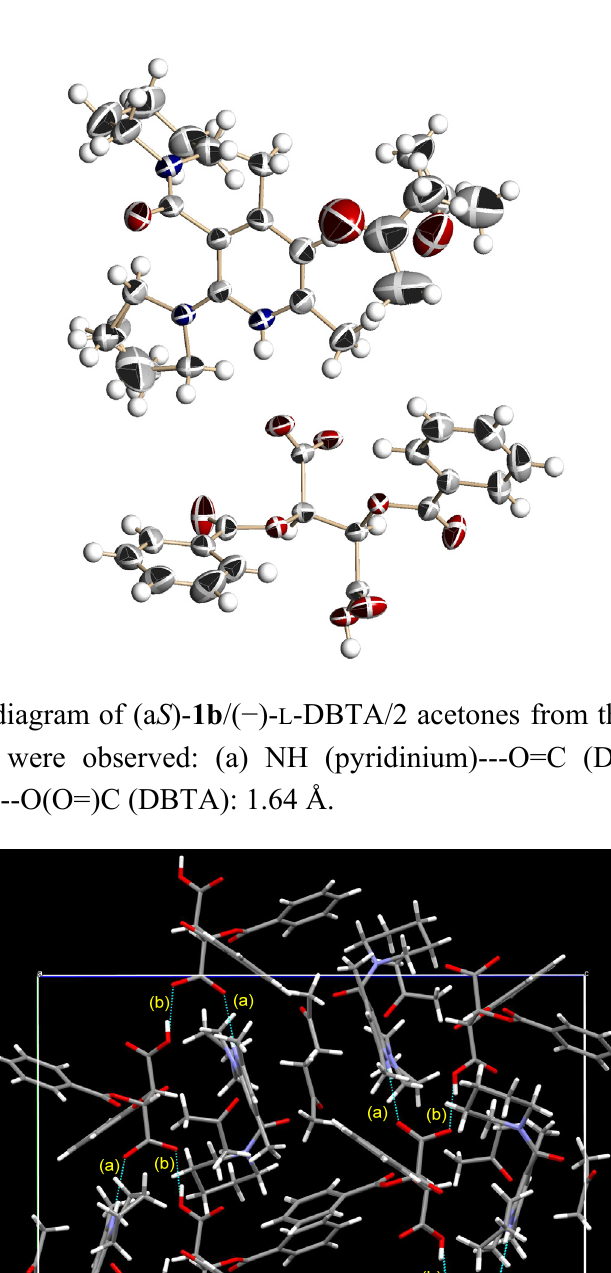
Figure 5. Perspective view of the chiral salt of (a S )- 1b and ( − )- L -DBTA with two acetone molecules (acetone molecules are omitted). The ellipsoids are shown as 40% probability. A hydrogen bond between NH (pyridinium) and O(O=)C ( L -DBTA) was observed, with a distance of 2.01 Å.